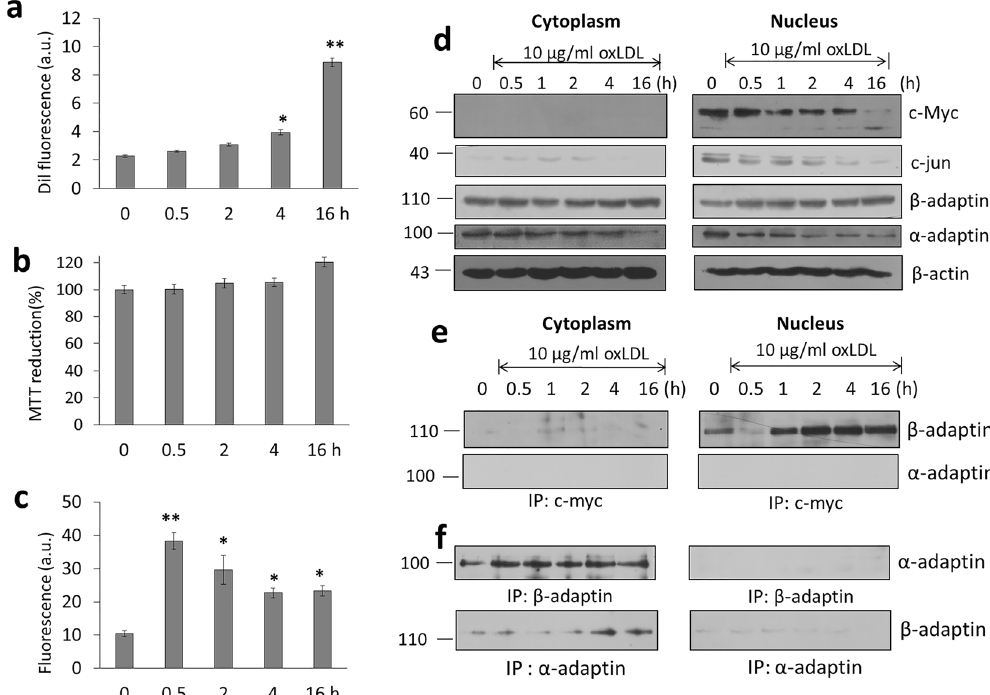
Figure 5. Internalization of oxLDL induces changes associated with the role of c-Myc and β -adaptin. ( a ) Internalization of oxLDL(10 µ g/ml) in macrophages during an interval of 0–16 h. ( b ) Under the same experimental conditions, cell viability was evaluated. ( c ) Fluorescence associated to ROS in macrophages treated with oxLDL. ( d ) Protein expression profile of β -adaptin, α -adaptin, c-Jun and c-Myc in nucleus and cytoplasm isolated. ( e ) Western blot of immunoprecipitation experimentation of c-Myc in macrophages incubated with oxLDL, detection of β -adaptin. ( f ) Control experiment for the interaction α -adaptin/ β -adaptin, part of the complex AP2. In all cases β -adaptin used as control. Mean values are presented (n = 6, X ± SD) * p < 0.05, ** p <